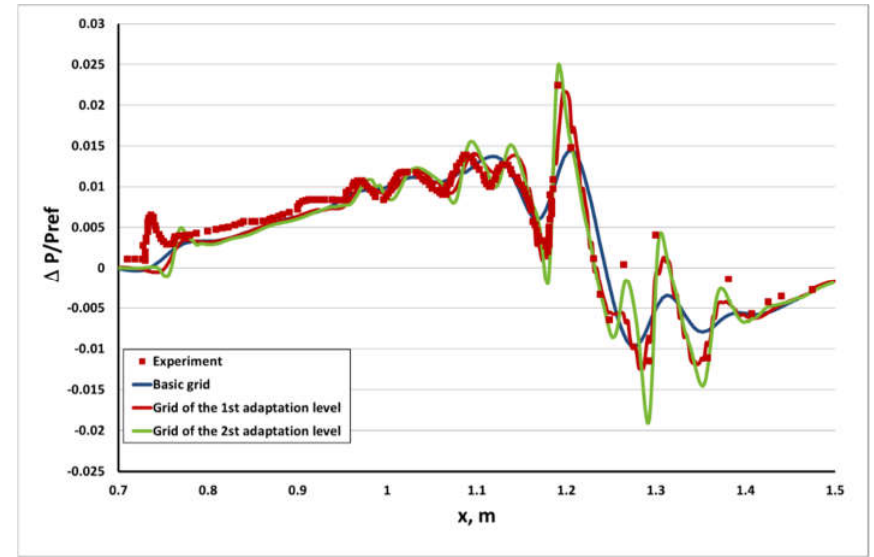
Figure 26. Result estimation scheme (LM1021).